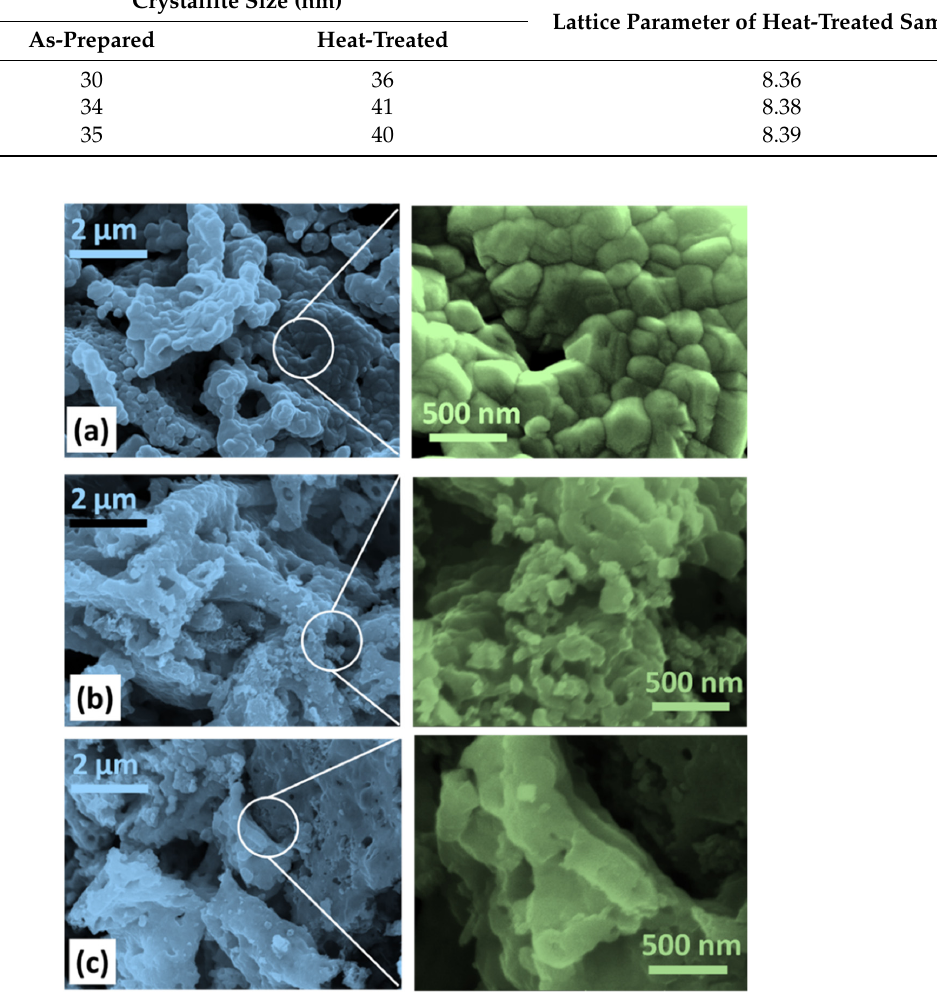
Figure 3. SEM images of MgFe 2-x O 4- δ (x = 0 ( a ), 0.05 ( b ), and 0.1 ( c )) ferrite, respectively.